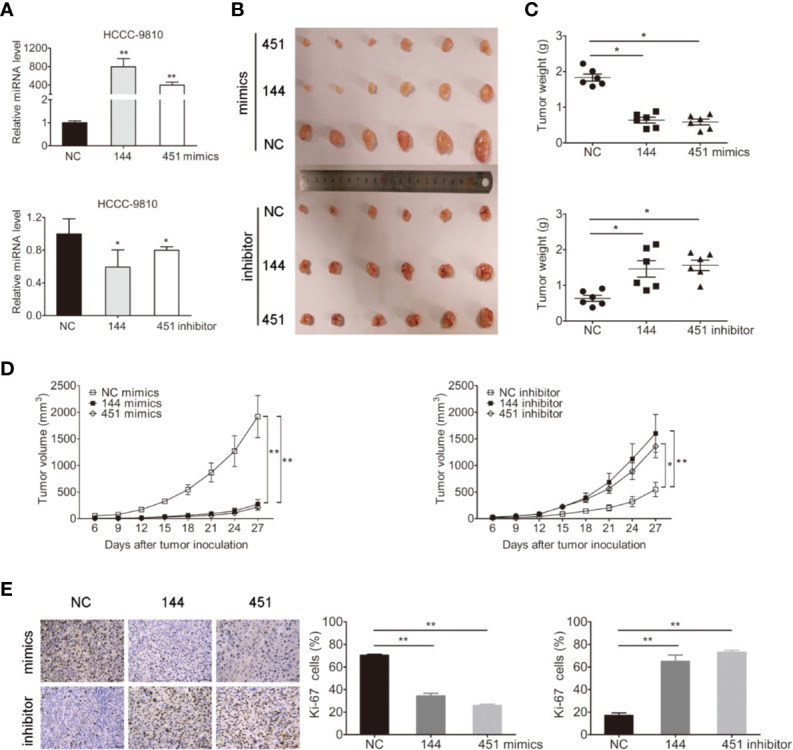
miR-144-5p and miR-451a changed tumor growth in vivo. (A) Using miR-144-5p and miR-451a mimics or inhibitor to overexpress or downregulate the expression of miRNA-144-5p and miRNA-451a in HCCC-9810 cells. (B) Representative images of xenograft tumors derived from miR-144-5p or miR-451a overexpressed- or knockeddown-HCCC-9810 cells. Mice were sacrificed 27 days after subcutaneous inoculation. (C) Tumor weight of xenografts. (D) Tumor volumes were monitored every 3 days. (E) Representative immunohistochemistry staining images of Ki-67 in the indicated tumor tissues, and quantification of Ki-67 positive cells. Bars represent mean ± S.D. (n = 6), *p < 0.05. **p < 0.01.